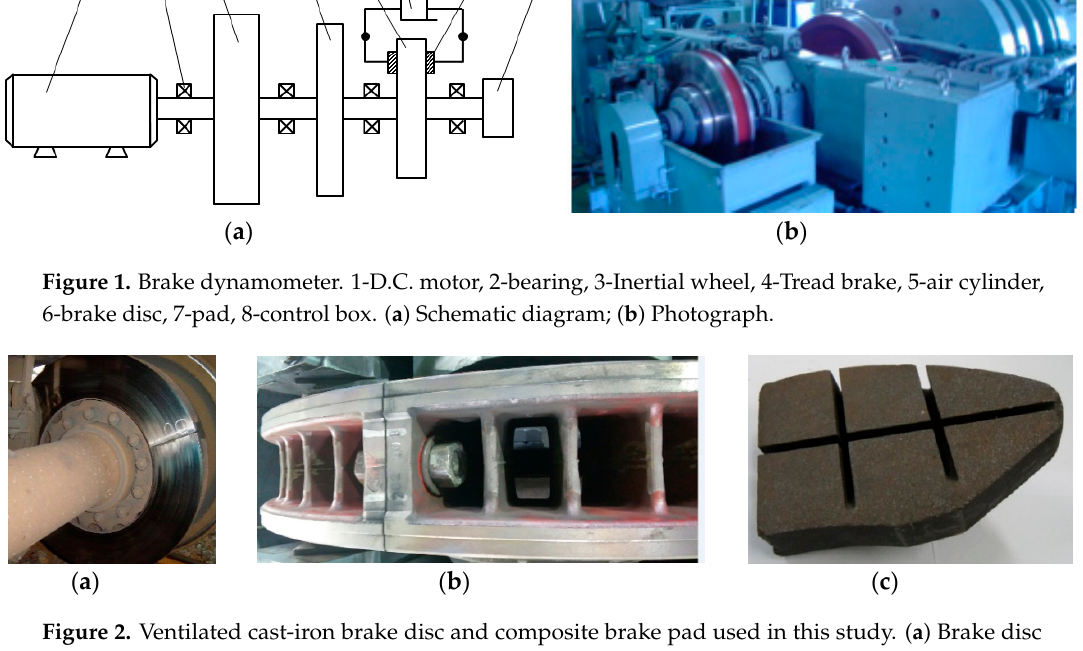
Figure 2. Ventilated cast-iron brake disc and composite brake pad used in this study. ( a ) Brake disc mounted to the axle; ( b ) Assembled brake disc; ( c ) Composite brake pad